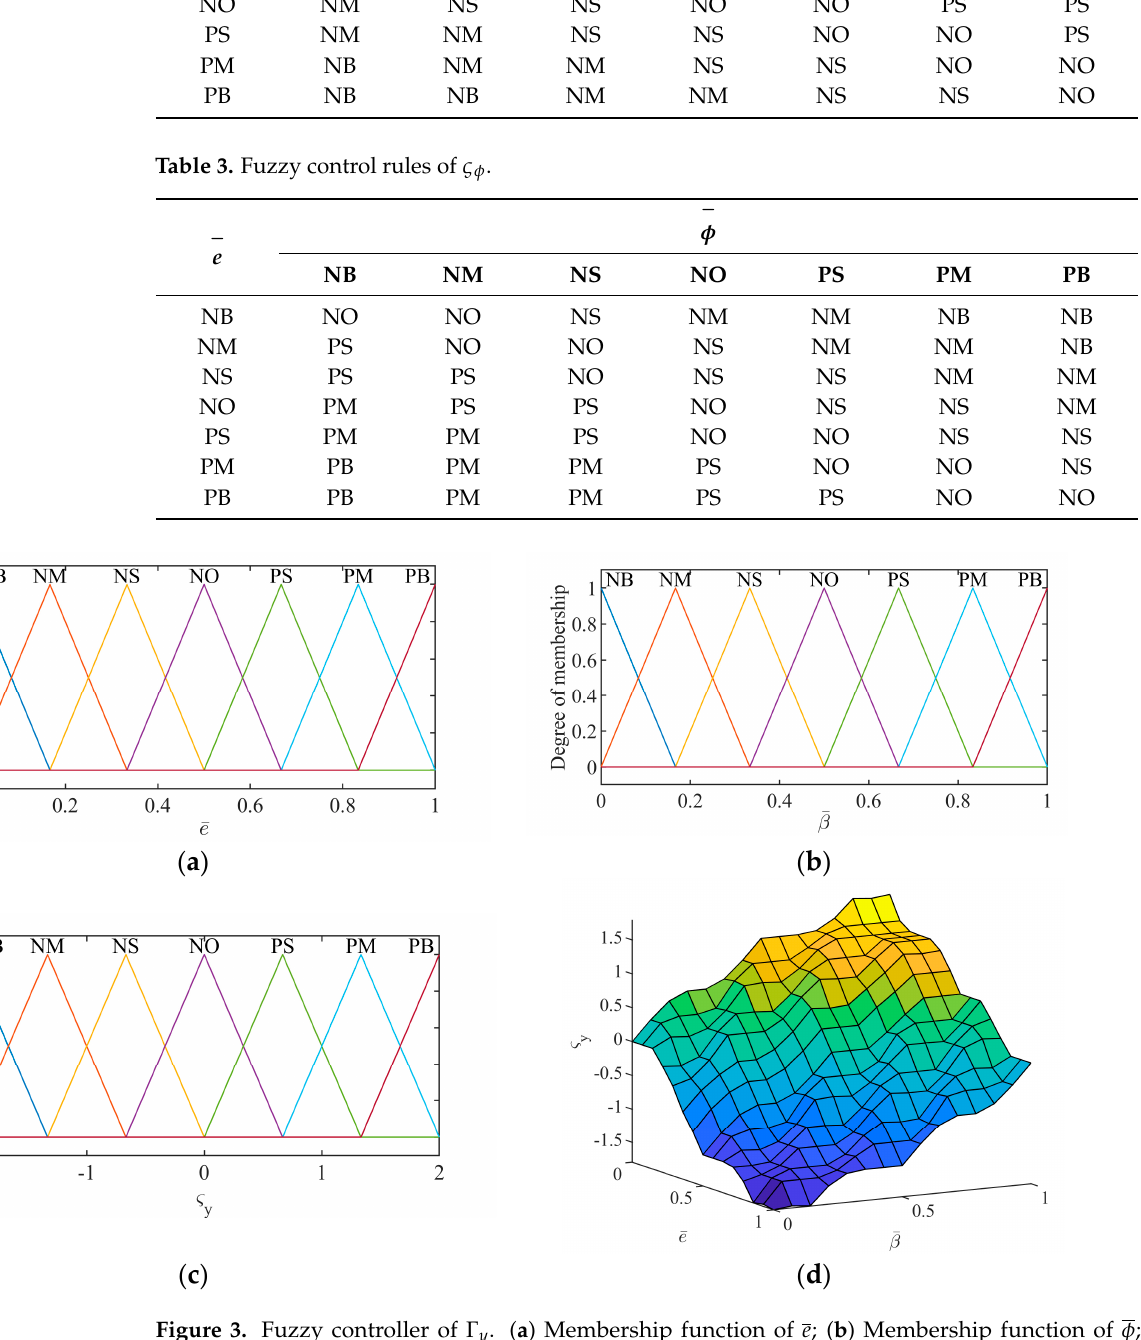
Γ . ( a ) Membership function of e ; ( b ) Membership function of φ ; ( c ) Figure 3. Fuzzy controller of Figure 3. Fuzzy controller of Γ y . ( a ) Membership function of e ; ( b ) Membership function of φ ; y ς ; ( d ) Three − dimensional map. ( c ) Membership function of ς y ; ( d ) Three-dimensional Membership function of y